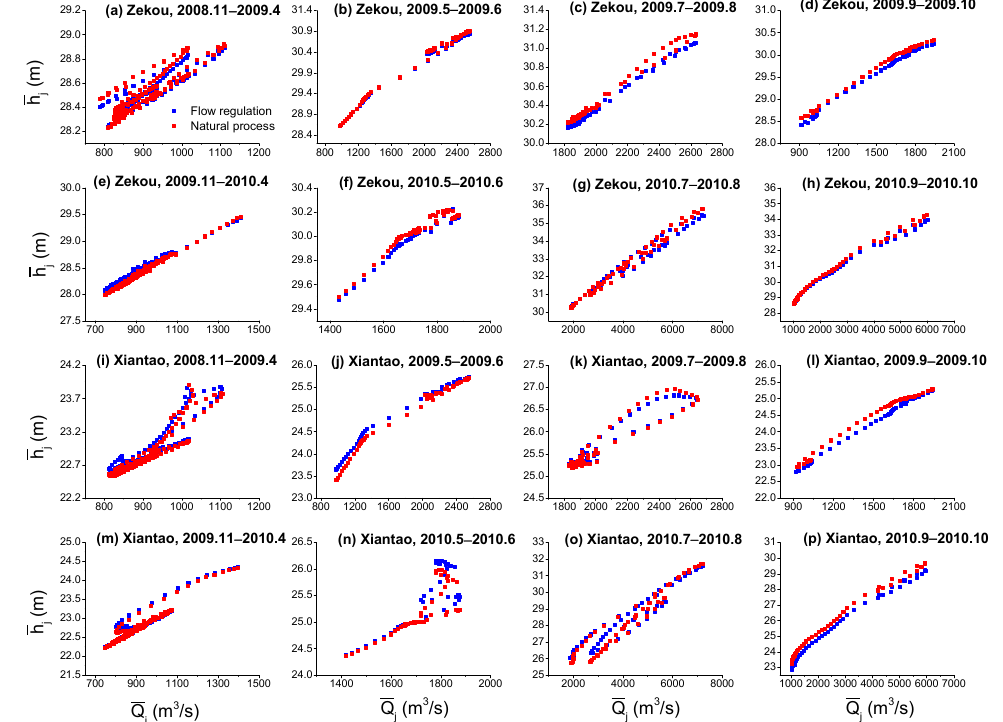
Figure 7. Stage-discharge relationships at the Zekou and Xiantao stations with and without the TGR from November 2008 to October 2010. h J and Q J are the 5-day moving average stage and flow respectively.